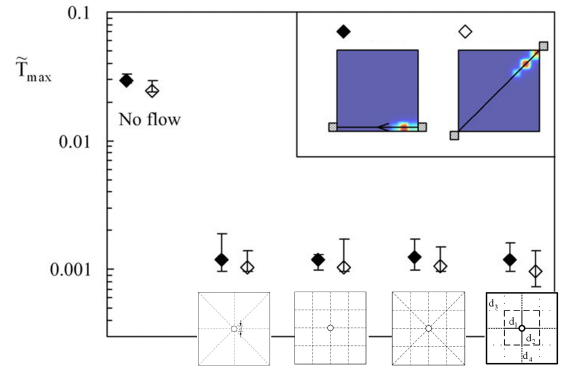
Figure 8: The average peak temperature in foure competing de-